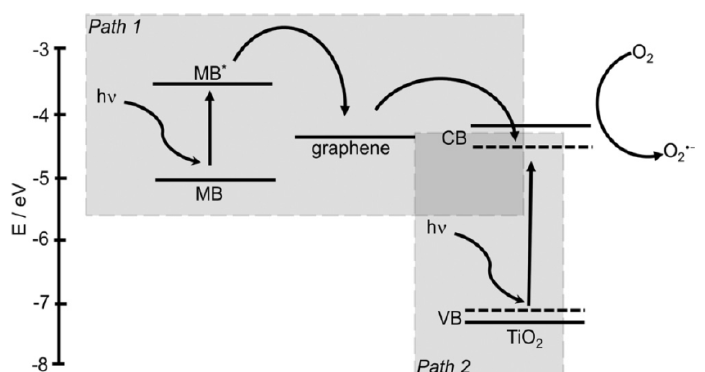
Figure 3. Proposed mechanism for the photodegradation of methylene blue (MB) by graphene-wrapped anatase nanoparticles under visible-light irradiation [10,83]. Reprinted with copyright permission from reference [83]. Copyright © 2012 WILEY-VCH Verlag GmbH & Co. KGaA, Weinheim,